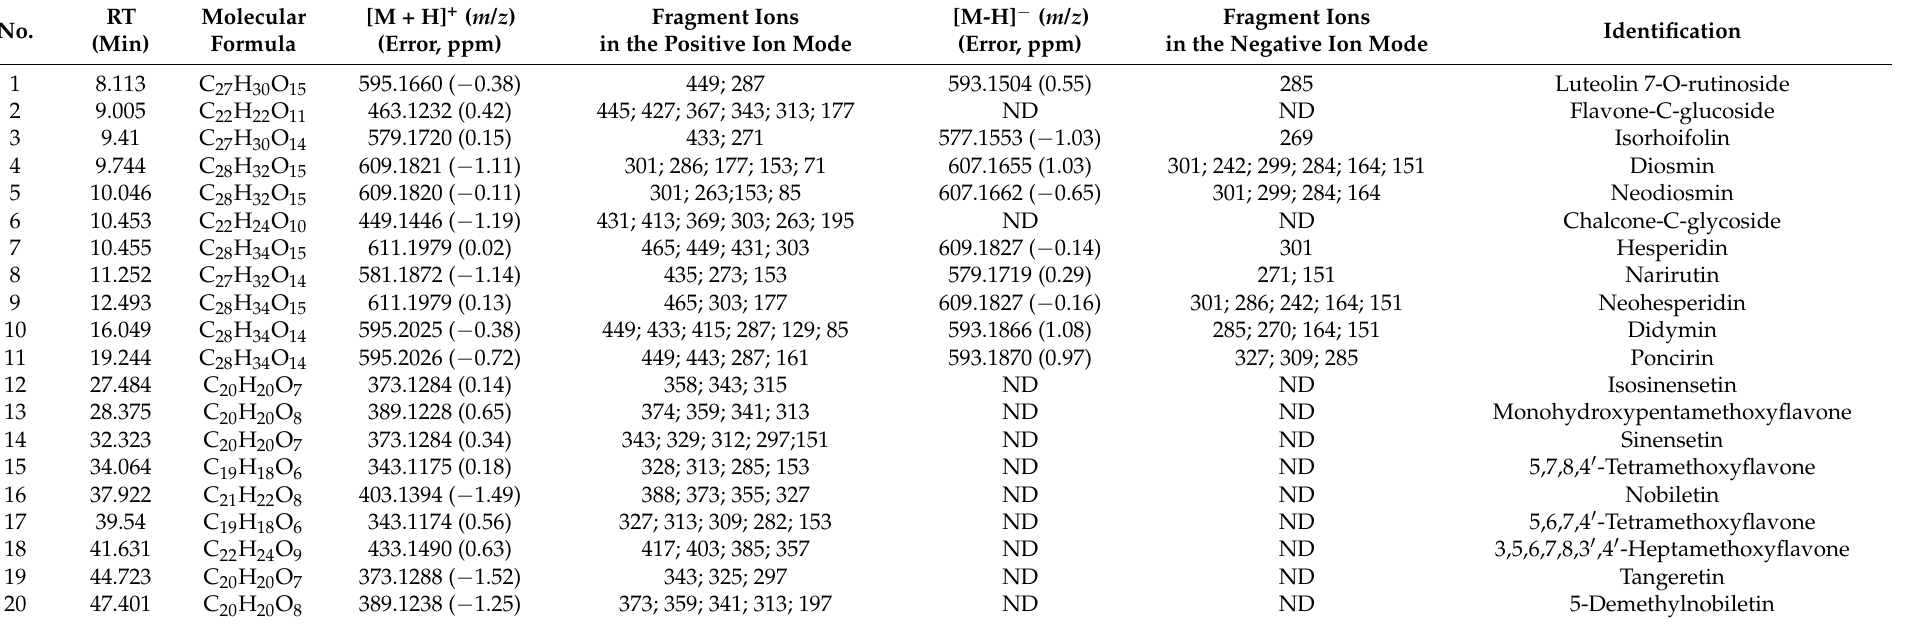
Table 2. Identification of the bound flavonoids of PCR-C by